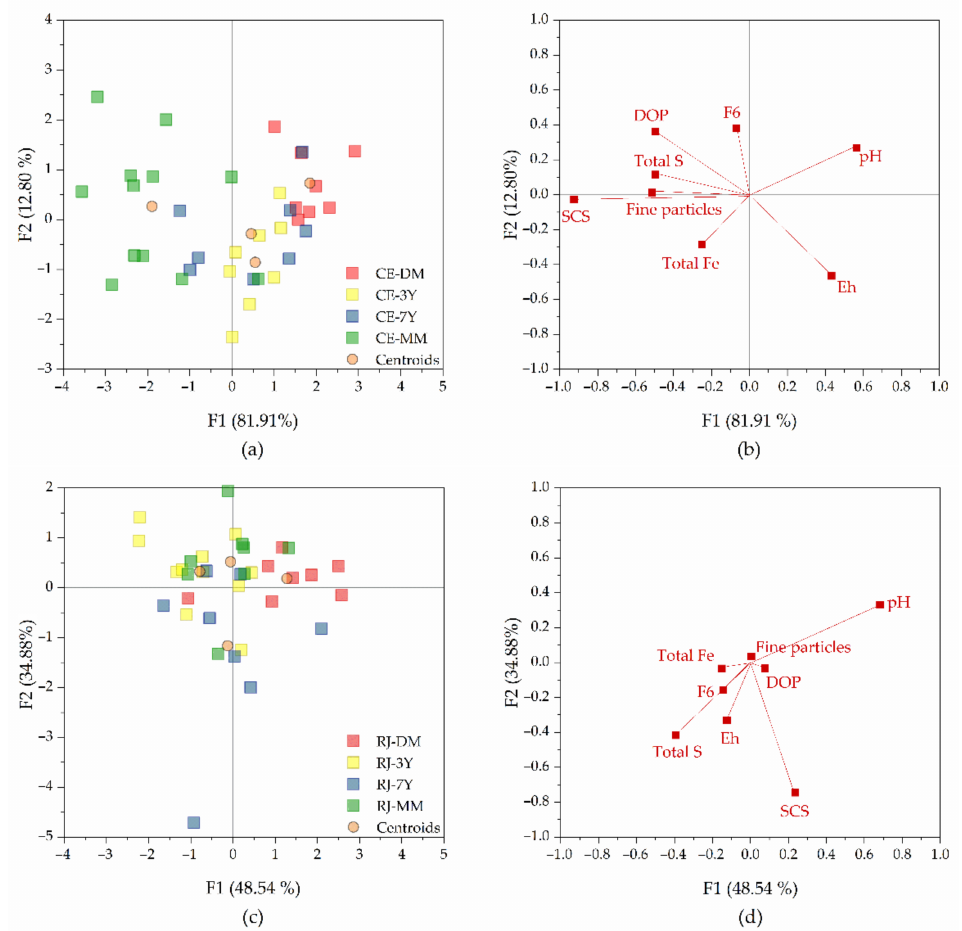
Figure 9. Discriminant analysis data for the studied soil variables in the Cear á ( a , b ) and Rio de Janeiro ( c , d ) sites. The squares on the right represent the correlations among the soil parameters that compose the two discriminant functions. Fine particles: Σ clay and silt; SCS: soil carbon stock; DOP: degree of